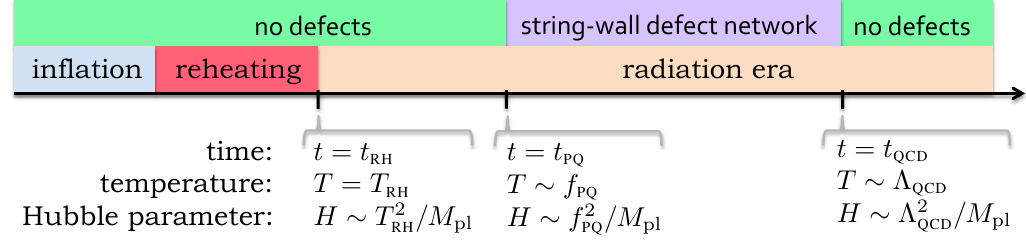
Figure 2 . A timeline illustrating the scenario in which symmetry breaking occurs during the radiation era, after reheating is completed. The defect network forms at the PQ-breaking phase transition, and it eventually collapses at the QCD epoch when instanton e(cid:11)ects lift the axion mass. Unlike the usual QCD axion cosmology, in the clockwork model the gear-(cid:12)eld domain walls form already at t pq